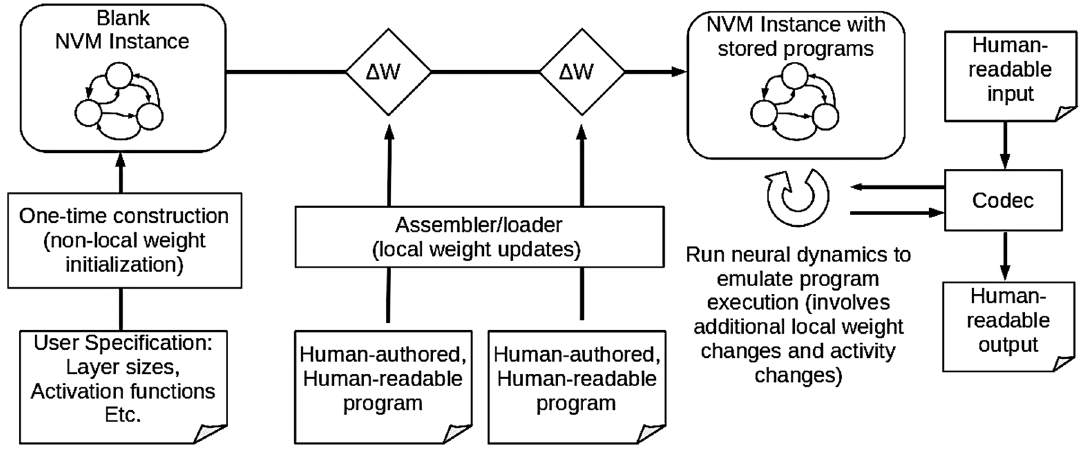
Figure 3: Using the NVM. After an initial description of a neurocomputational model’s architecture (leftmost), human- authored programs are learned by that neural architecture (middle left) using local learning rules. Execution of the stored program(s) is emulated by running the dynamics of the underlying recurrent neural networks (middle right), which involves additional fast local weight updates. During execution a “codec” (coder-decoder) converts between the neural representations and human-readable input/output